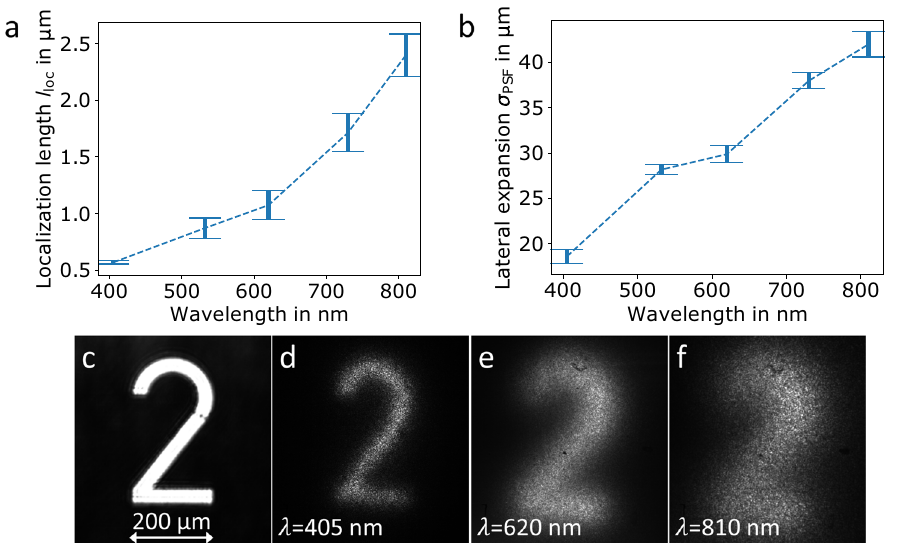
Fig. 4 Scaling analysis: simulation and experiment. Propagation parameters in phase-separated fi ber (PSF) for different wavelengths. a Mean localization length (localized mode size, l loc ), obtained from numerical simulation, based on a contrast image of the PSF cross-section (see Methods). The localization length increases with the wavelength. We calculated the error bars as the sample s.d. for the 5 smallest localized modes per data point (wavelength). b As a comparison, we display experimental data: the lateral expansion during transport through PSF, de fi ned as s.d. σ PSF of a Gaussian point-spread function. As the localized modes from a enlarge, so does σ PSF . The error bars show the sample s.d. over 17 – 18 measurements per data point (wavelength λ ). c – f Wavelength-dependent image transport; the same input c transported through the same part of the PSF. Image quality degrades throughout the visible spectrum when increasing the wavelength of